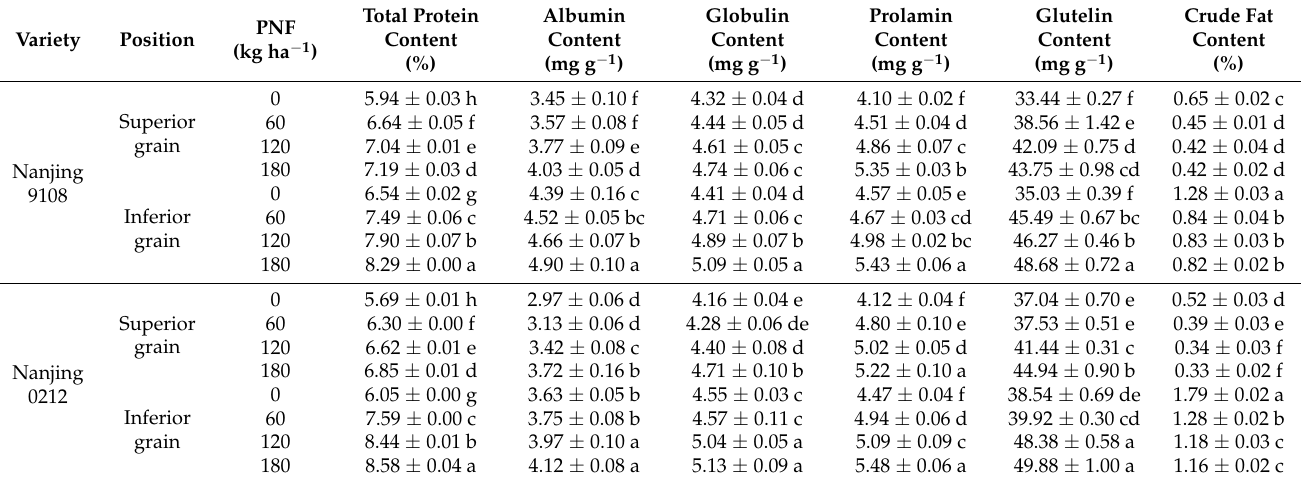
Table 2. Contents of total protein, protein components and crude fat in superior and inferior grains of japonica rice under different PNF